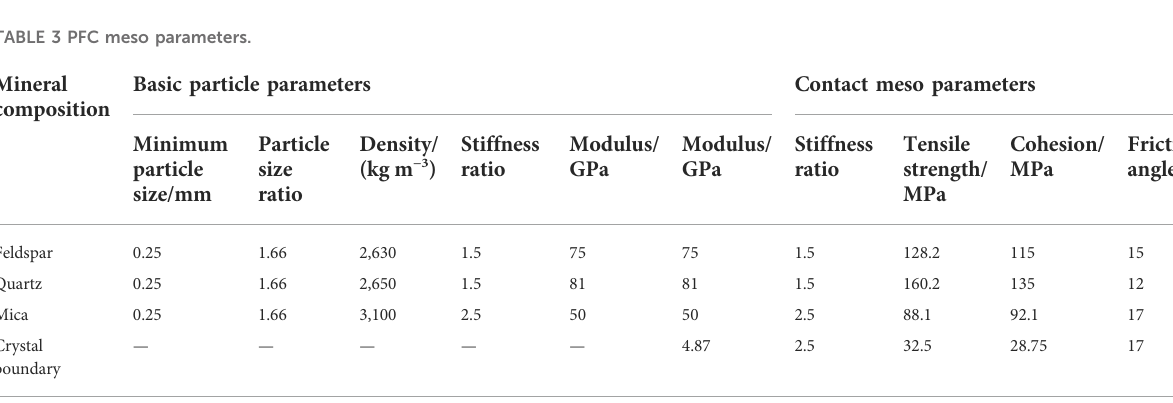
Figure 8 and Table 5.